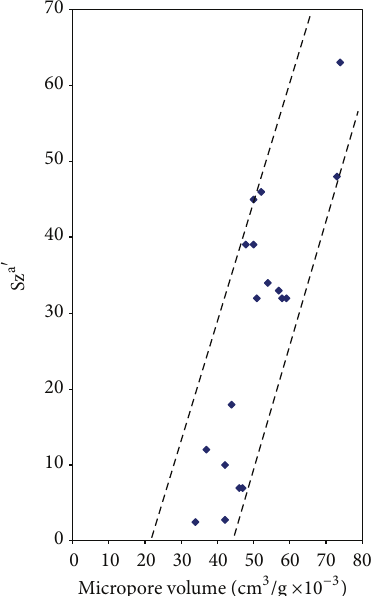
󸀠 of coal as a Figure 3: Value of spontaneous combustion index Sz a of coal as a function of macropore surface